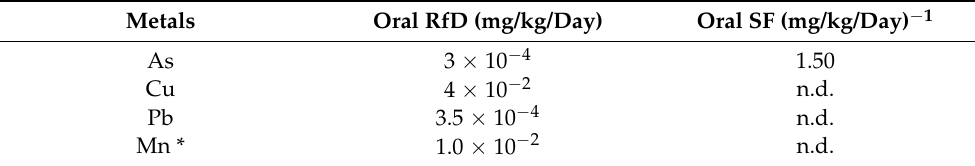
Table 2. Toxicity responses (dose response) to metals as the oral reference dose (RfD) and oral slope factor (SF).